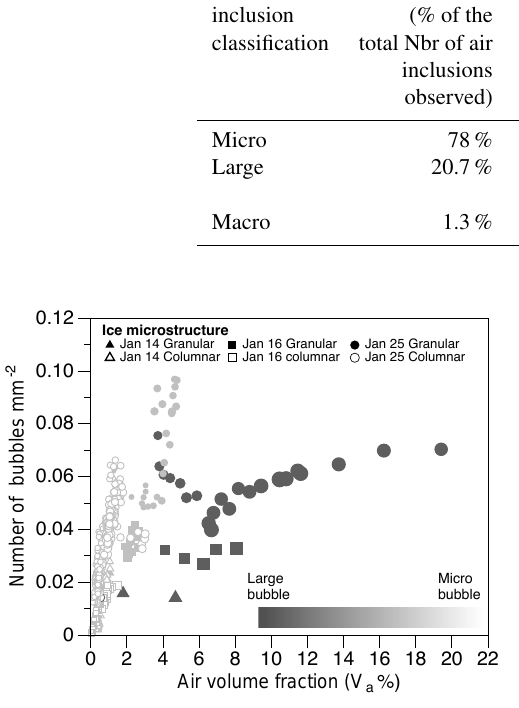
Figure 12. The relationship between bubble density: number of bubbles per mm − 2 (slice area) and air volume fraction per slice as a function of both bubble size class and ice type (granular and columnar crystal